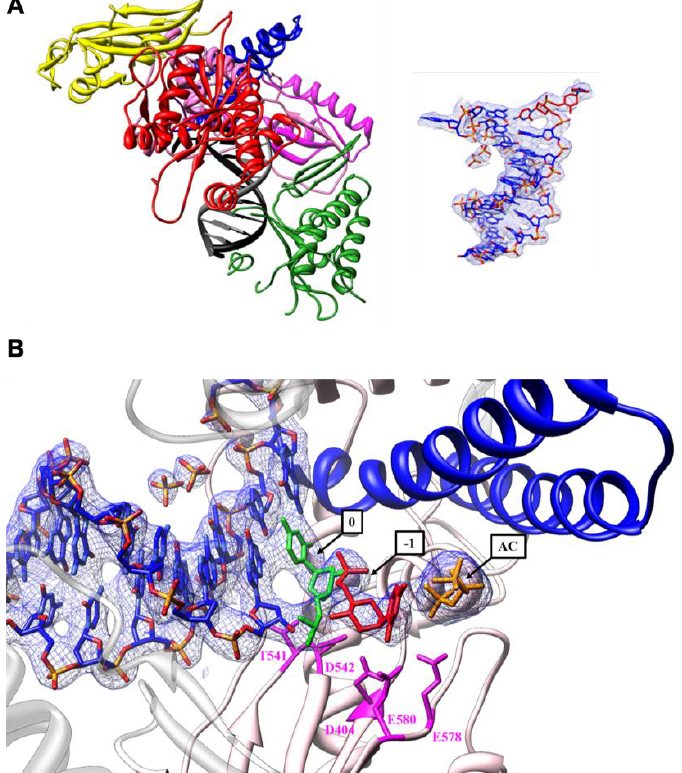
Figure 7. TgoT_6G12 trapped in a 1 nt-backtracked state after HNA synthesis. ( A ) Overall structure of TgoT_6G12 in binary complex, which has two incorporated hCs in the 3′ end of the DNA primer. The primer and template strands are colored in grey and black, respectively. The domains are colored as indicated in Figure 1B. On the right, the electron density of the primer-template duplex is shown at 1 σ as a blue mesh. The two incorporated hCs are labeled in red. ( B ) TgoT_6G12 active site with two incorporated hCs, colored in green and red. The finger and palm subdomains are colored in blue and light pink, respectively. The two hCs make contacts with residues of the palm domain (D404, T541, D542, E578 and E580), labeled in magenta. The position of each hCTP is labeled by an arrow (Position 1 and 0). The additional triphosphate in the antechamber is colored in orange, labeled AC.